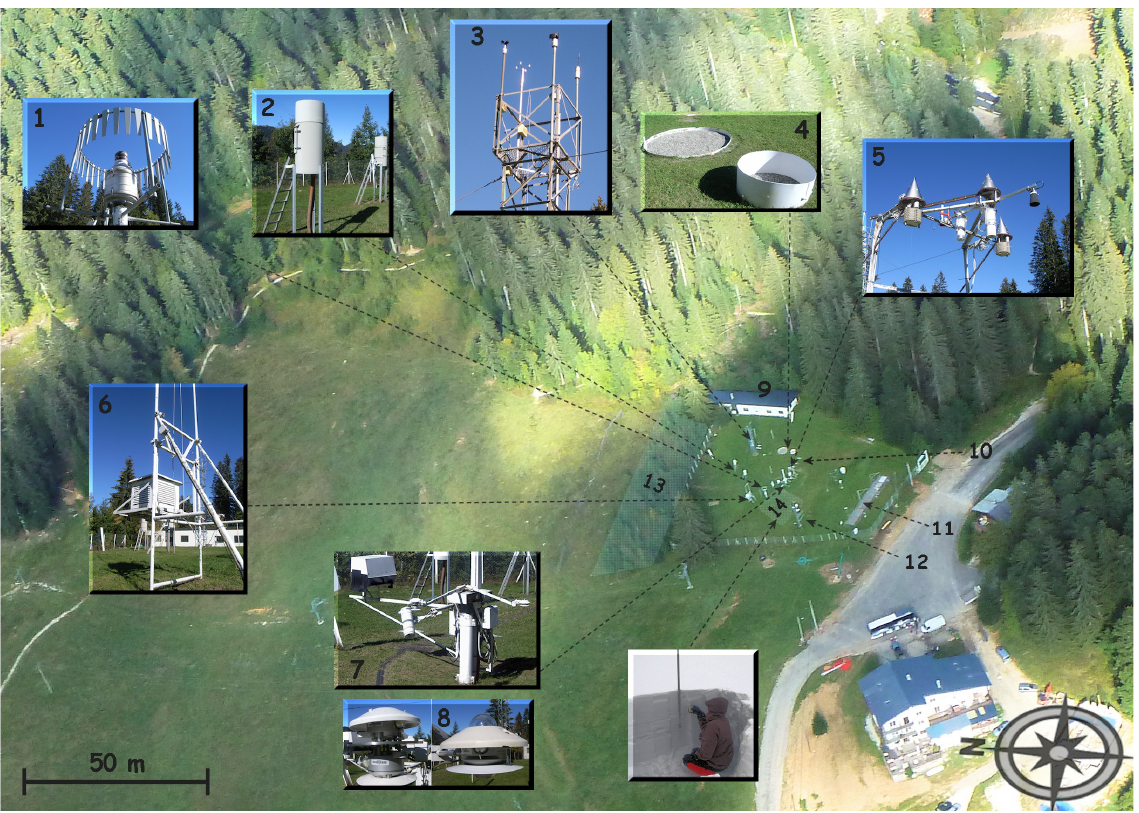
Figure 1. Overview of the experimental site at Col de Porte (1325m altitude, Chartreuse mountain range, France). All sensors are located within a radius of a few tens of meters. (1) Geonor precipitation gauge, (2) PG2000 heated and non-heated precipitation gauges, (3) windspeed measurements at the top of the 10m meteorological mast, (4) lysimeters, (5) snow depth sensors and settling disks, (6) temperature and relative humidity sensors placed in the shelter, (7) radiation sensors placed on the rotating arm, (8) close-up on the 4 components radiation sensors, (9) building (cold room, data acquisition, lab space), (10) cosmic rays counter for SWE measurements, (11) former experimental area for the study of road / snow interactions, (12) automatic snow and weather station Nivose for testing purposes (generally used in remote mountain areas), (13) forest area impacted by the cut in 1999, (14) snow pit area. See text for further details on